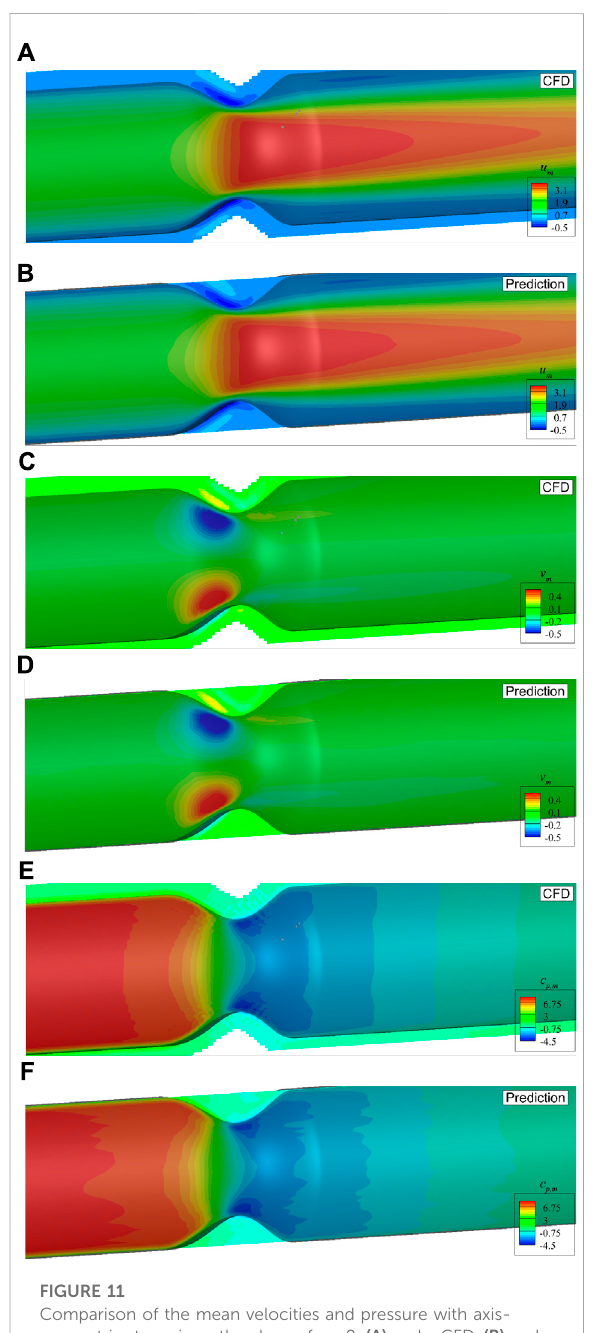
FIGURE 11 Comparison of the mean velocities and pressure with axis- symmetric stenosis on the plane of z = 0: (A) u m by CFD, (B) u m by DNN prediction, (C) v m by CFD, (D) v m by DNN prediction, (E) c p , m by CFD, (F) c p , m by DNN